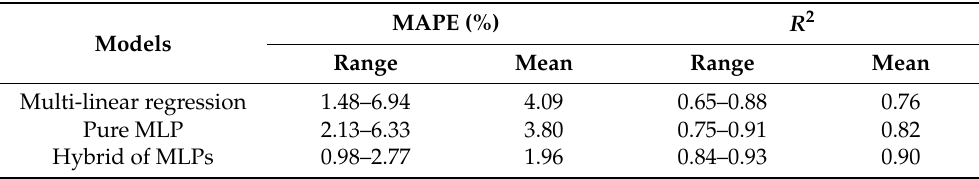
Table 3. Accuracy of high-resolution air temperature maps generated using three models. MAPE (%) R 2 Models Range Mean Range Multi-linear regression